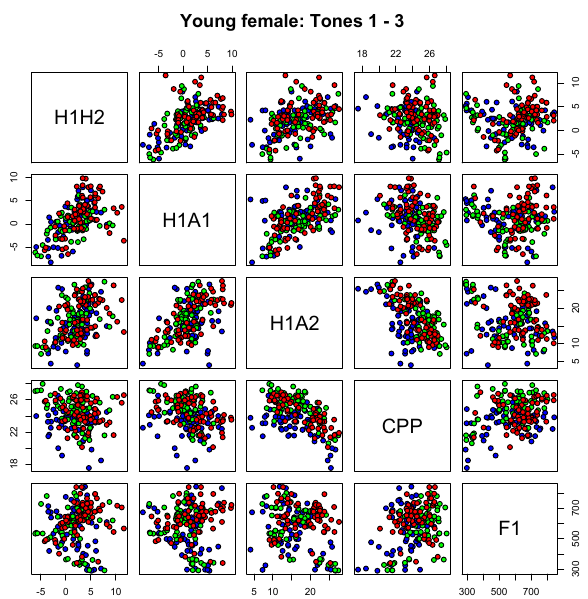
Figure 4 : Scatterplot matrices with five acoustic measures of breathiness for young females: blue for T1, green for T2, and red for T3.